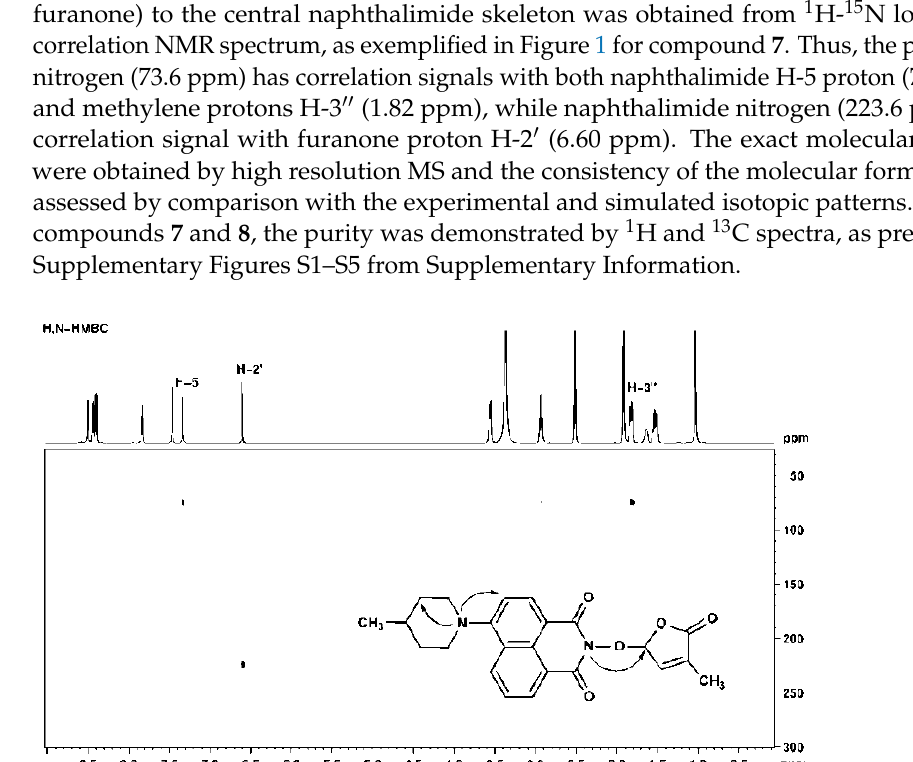
sorption spectra of naphthalimide derivatives show a broad absorption band in the visi- ble range, located at 402 nm for 7 , in dioxane (Figure 2a). This absorption band can be assignable to a π - π * transition due to the naphthalimide moiety [10,47,48]. A shift to longer wavelength of visible absorption band was observed as the solvent polarity in- creased (Table 1). Thus, a red shift of 20 nm of the position of the absorption band of 7 was found for DMSO and this shift was of 16 nm in DCM relating to a non-polar solvent (dioxane). However, due to the electron-donating character of the piperidine unit, an in- tramolecular charge transfer from this group to the naphthalimide fragment can be gen- erated [35,49]. The charge transfer character of this transition is proved by the red shift of the absorption band around 400 nm passing to a nonpolar solvent to a polar one. The high molar absorptivity ( ε = 11,300 mol − 1 Lcm − 1 , 8 ) shows also that this electronic transi- tion from the ground state to the excited state for naphthalimides possesses a π - π * char- acter. As can be seen from the data comprised in Table 1, the solvent effect is more pro- nounced on the emission bands than on the absorption bands. In this case, the spectral shift owing to the high solvent polarity is much greater, increasing practically two fold relating to the absorption shift. The emission spectra of piperidine-naphthalimide deriv- atives obtained by excitation in the absorption band maximum exhibit an emission band in the range 495–540 nm depending on the solvent polarity (Figure 2b and Table 1). For example, the derivative 7 shows a yellow green emission at 495.5 nm in toluene, which is red shifted to 536 nm in DMF. These naphthalimides exhibit very strong emission in nonpolar solvents (dioxane, Φ = 0.821 ( 7 ); toluene, Φ = 0.453 ( 8 ); DCM, Φ = 0.530 ( 8 )), while in polar solvents the quantum efficiency of emission decreases drastically (ace- tonitrile, Φ = 0.106 ( 7 ); DMSO, Φ = 0.003 ( 8 )) (Table 1). The decrease of emission intensity in polar solvents can be assigned to a possible photoinduced electron transfer (PET) from the piperidine unit to the excited state of the naphthalimide fluorophore [35]. In this way, the emission of the naphthalimide derivatives 7, 8 in polar media is quenched. Recently, the decrease of the quantum yield in polar solvents was attributable to the presence of a twisted intramolecular charge transfer process in piperidine-naphthalimides, which leads to more stabilized excited states in polar solvents [49,50].